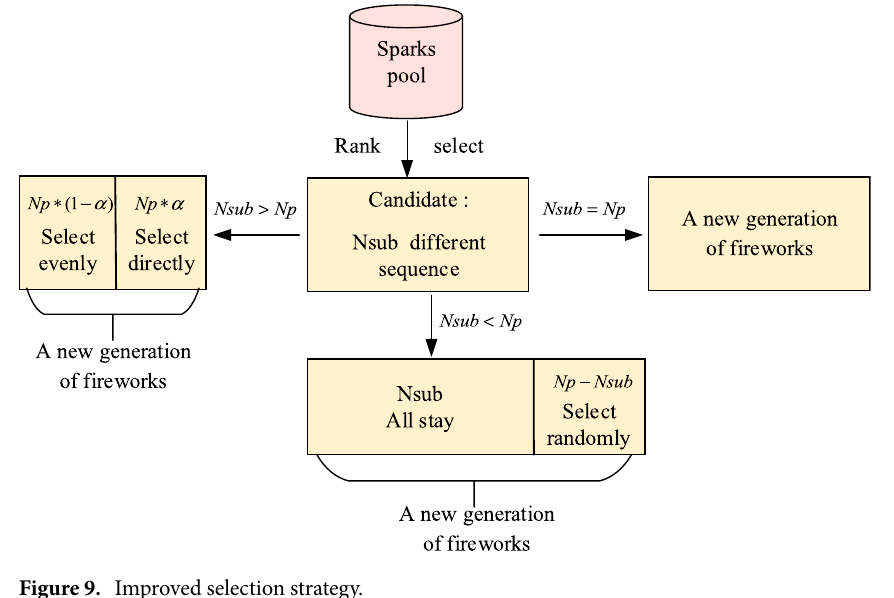
Figure 9. Improved selection strategy.